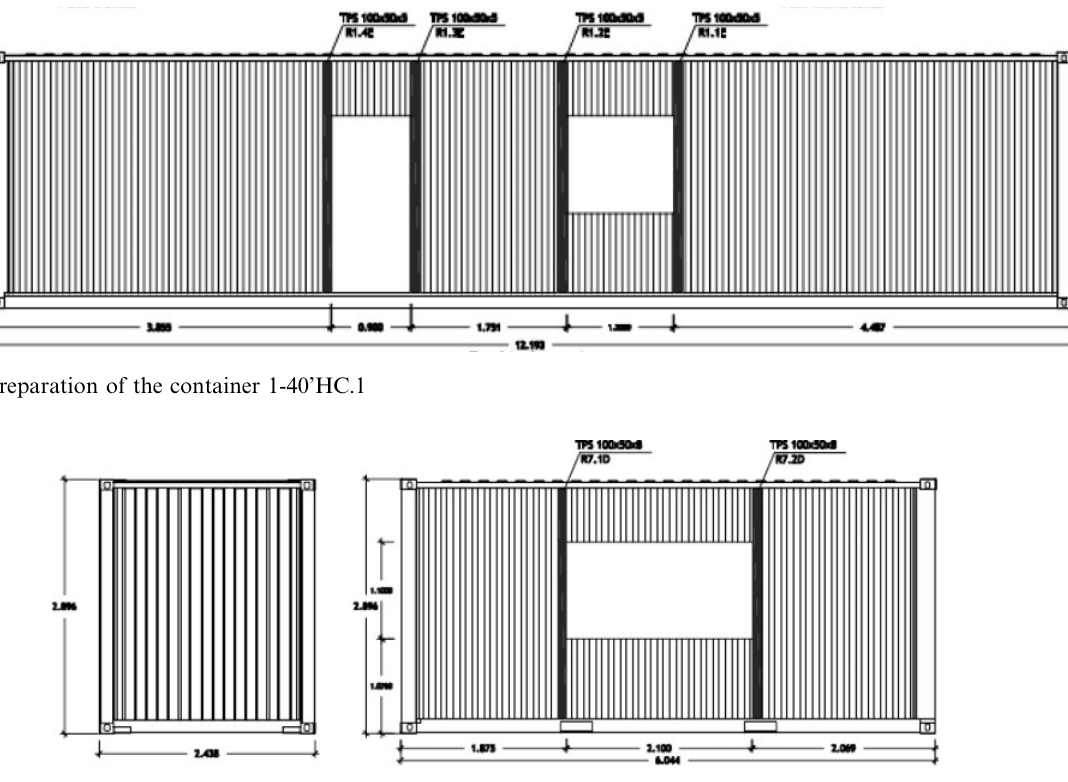
Fig. 16. Preparation of the container